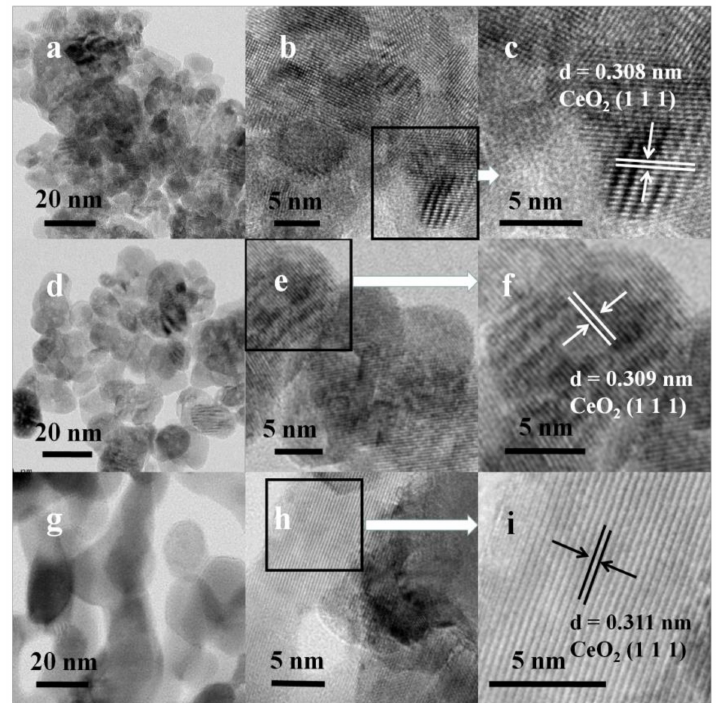
Figure 7. TEM profiles of Co / CeO 2 -h( a – c ), Co / CeO 2 -p( d – f ) and Co / CeO 2 -c( g – i